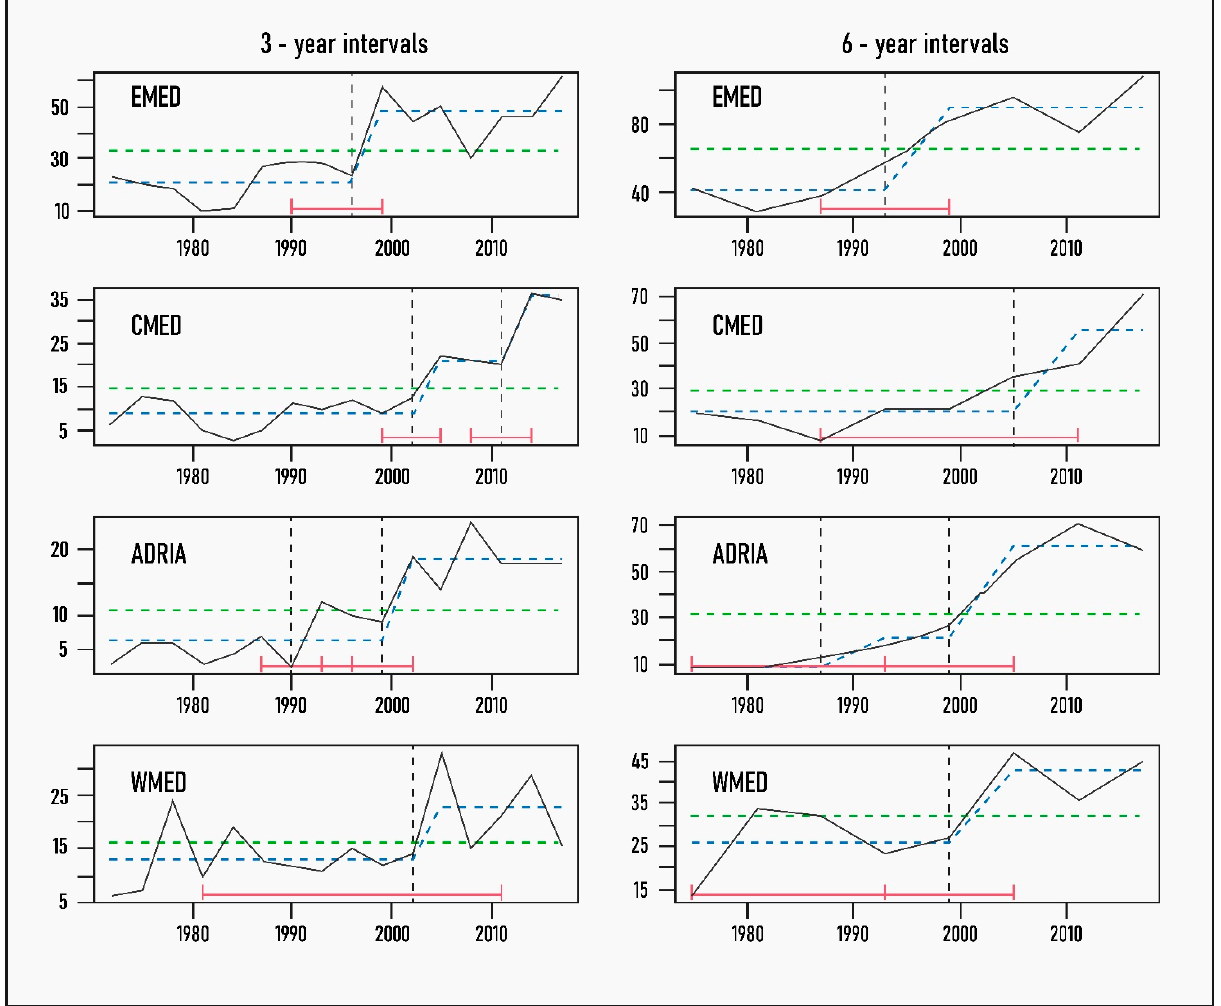
Figure 4. Trends in new NIS introductions, including Lessepsian fishes and parasites, in different Mediterranean subregions by 3- and 6-year increments (continuous black line) with breakpoints and fitted mean values superimposed: vertical dashed line indicates breakpoint or year of significant change in the mean values of new NIS, with 95% confidence intervals in red brackets; dashed green line shows the null model of no temporal change in new NIS numbers; and dashed blue line represents fitted mean values before and after the identified breakpoint. The absence of red CI bars indicates that 95% CIs could not be computed as they fell outside the data time interval.